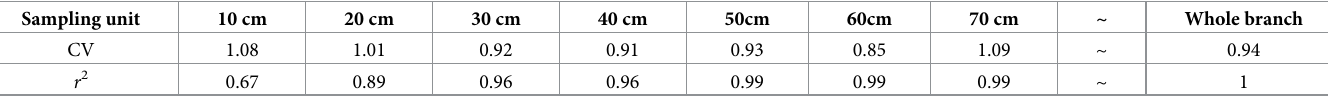
Table 2. Coefficient of variance (CV) for counts of R . shantungensis egg masses according to selected sampling locations from the tip within terminal branches and coefficient of determination ( r 2 ) of the linear regressions of egg mass counts between on selected sample locations within a terminal branch and on its whole